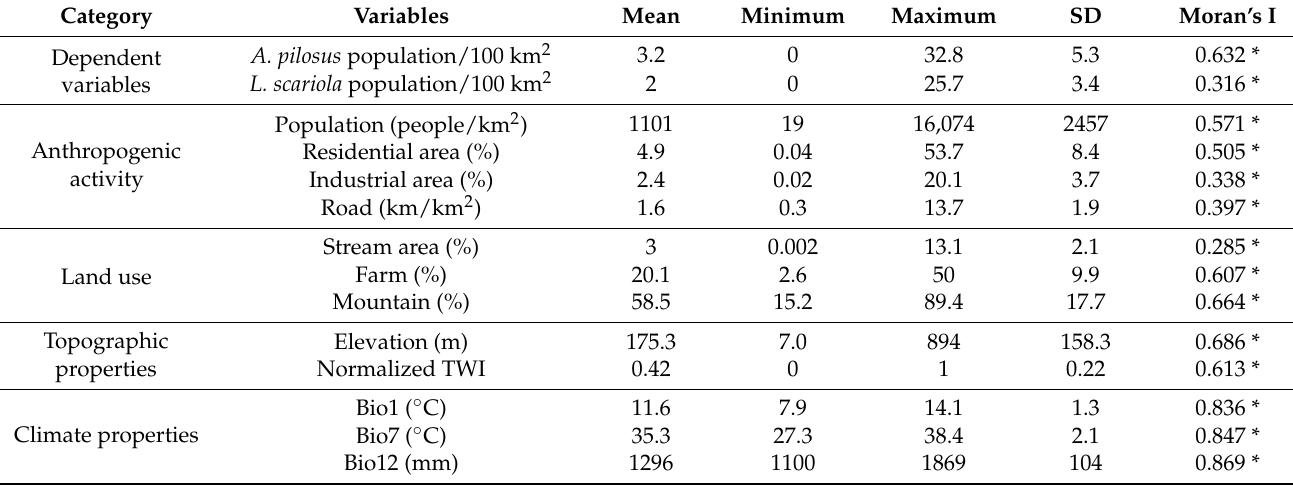
Table 2. Descriptive statistics of A. pilosus and L. scariola population density and 12 explanatory variables in 165 districts.